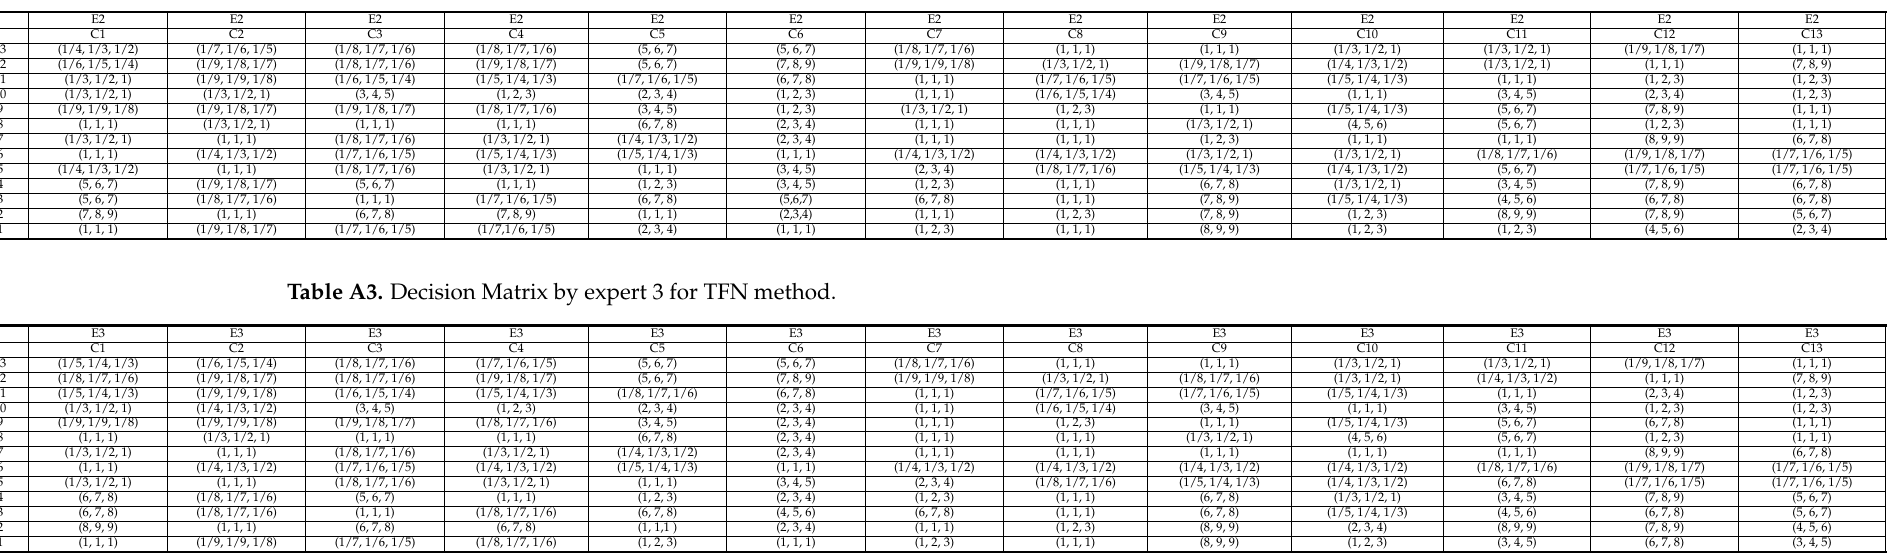
Table A2. Decision Matrix by expert 2 for TFN method.